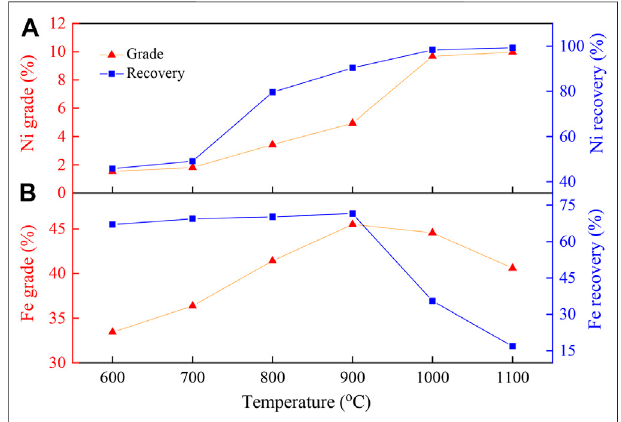
FIGURE 3 | Effect of reduction temperature on (A) nickel and (B) iron